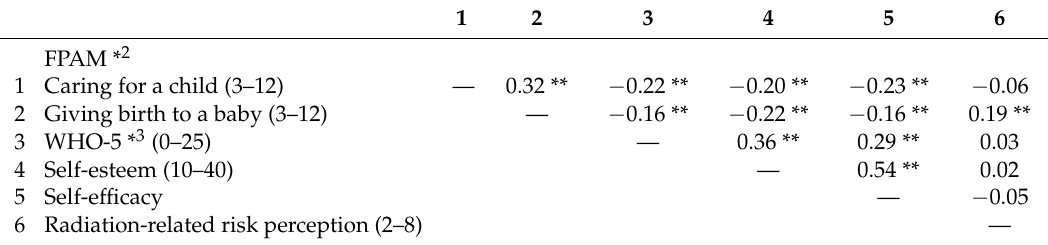
Table 3. Correlations between scales * 1 .